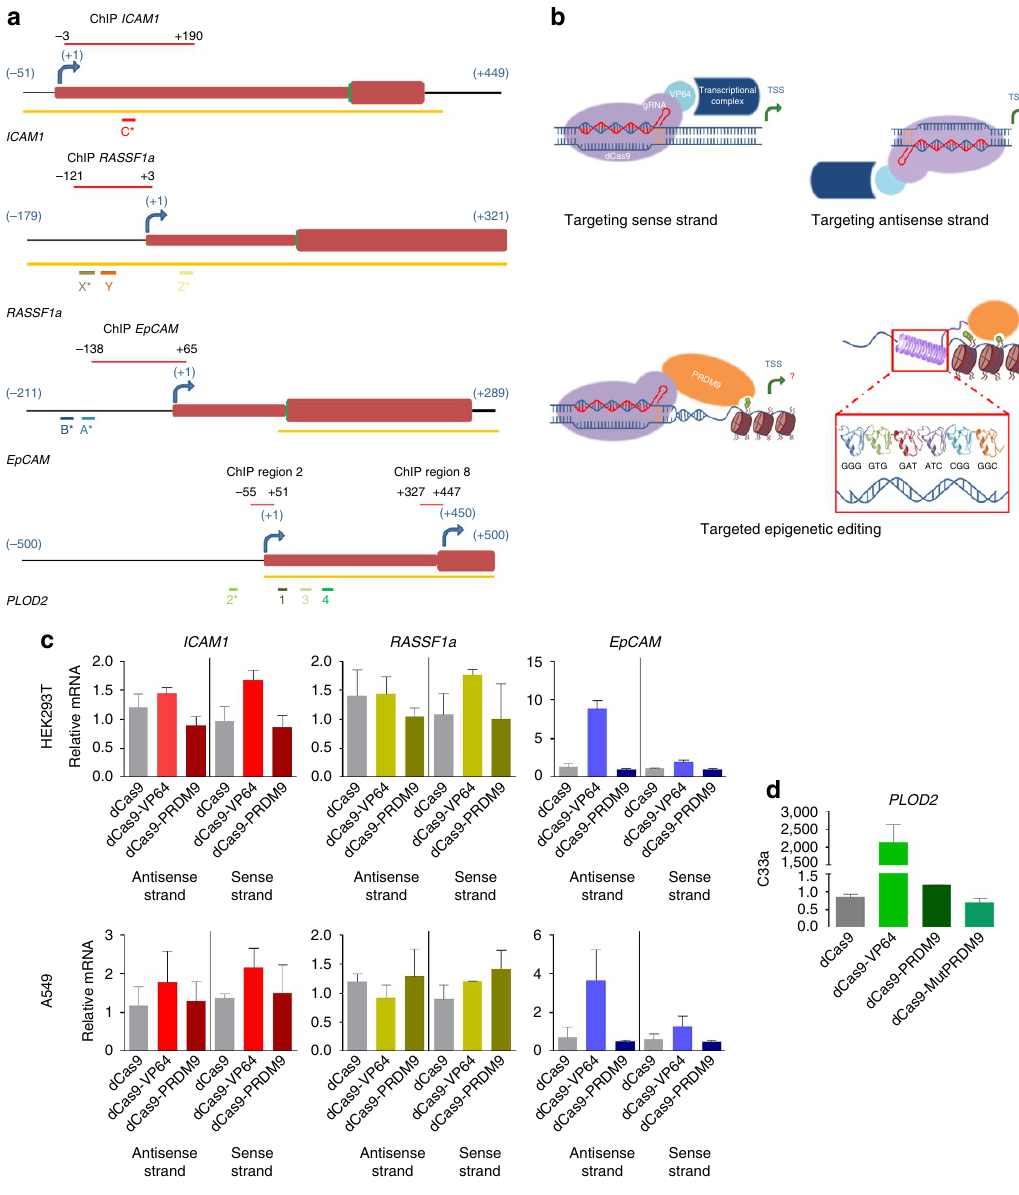
Figure 1 | Local induction of H3K4me3 activates transcription of endogenous genes from promoter regions using CRISPR–dCas9. ( a ) Schematic representation of the targeted genes and the (overlapping) locations where the ZFs and gRNAs bind (the letter or number of each region refers to the name of the ZF or gRNA, for the regions marked with * a ZF as well as a gRNA were designed). The yellow bars represent the location of the CpG islands. ( b ) Schematic of dCas9-VP64 targeting sense and antisense strands of DNA, and dCas9 and ZF fused to the epigenetic editor PRDM9 to locally induce H3K4me3. ( c ) Relative messenger RNA (mRNA) expression of ICAM1 , RASSF1a and EpCAM in HEK293Tand A549 cells, and ( d ) PLOD2 in C33a cells, by the indicated dCas9 fusion protein co-transfected with a combination gRNAs targeted to each promoter region. ( n ¼ 3 independent experiments; error bars ± s.d.).